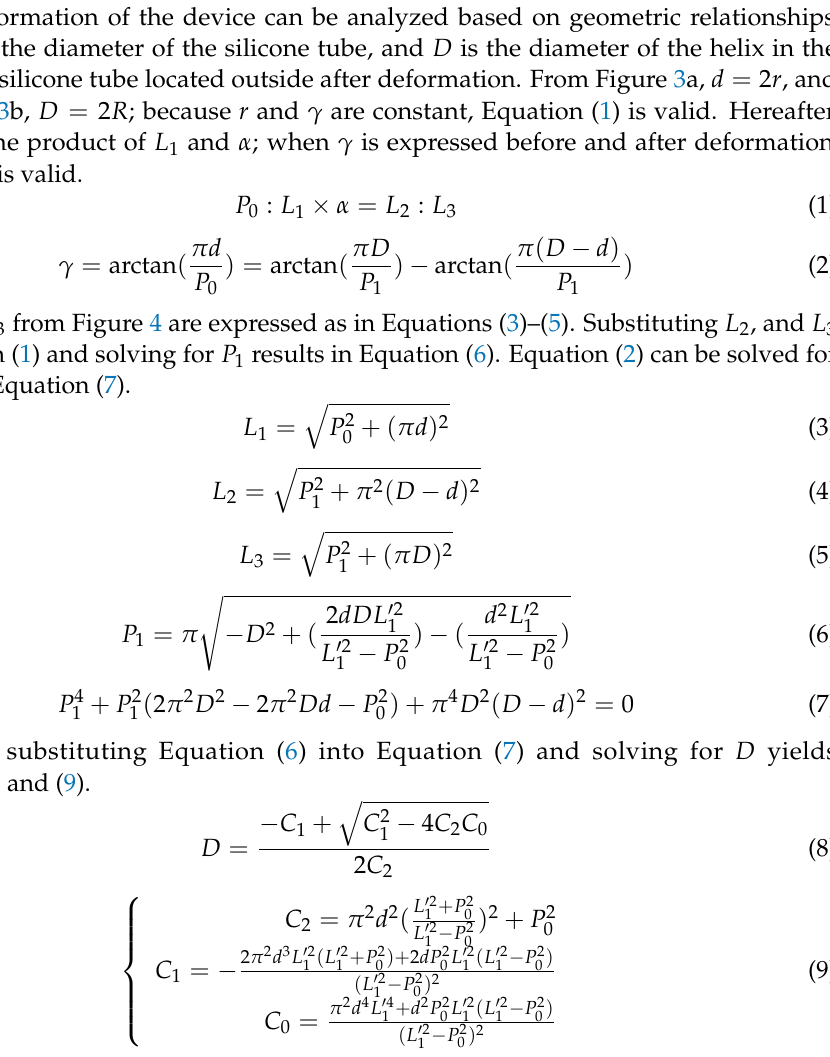
Figure 4. Expanded model where ( a , b ) show the device before deformation and after deforma- tion,